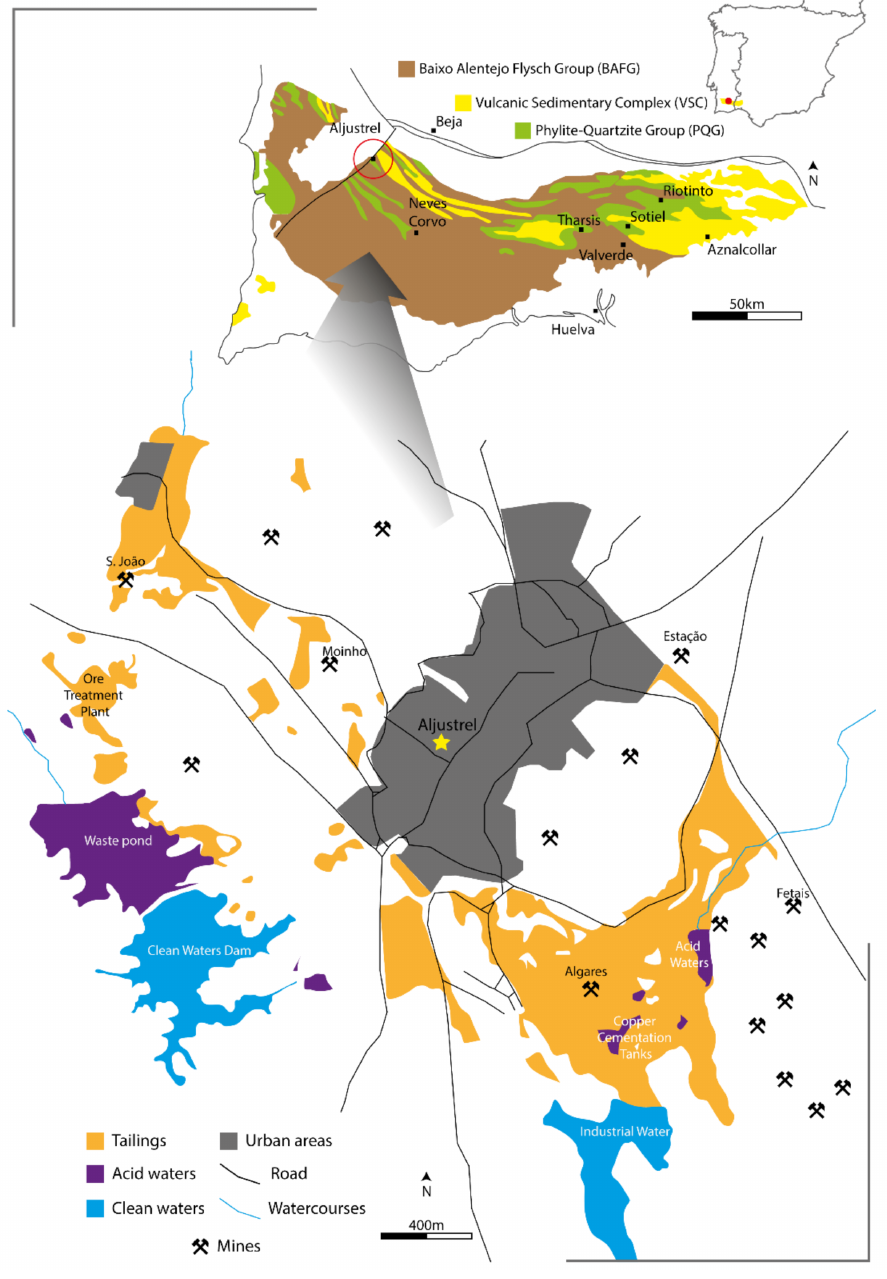
Figure 1. Simplified map of impacted areas in the Aljustrel mine, with the geological setting of the Iberian Pyrite Belt (IPB) in the upper right corner of the figure (adapted from